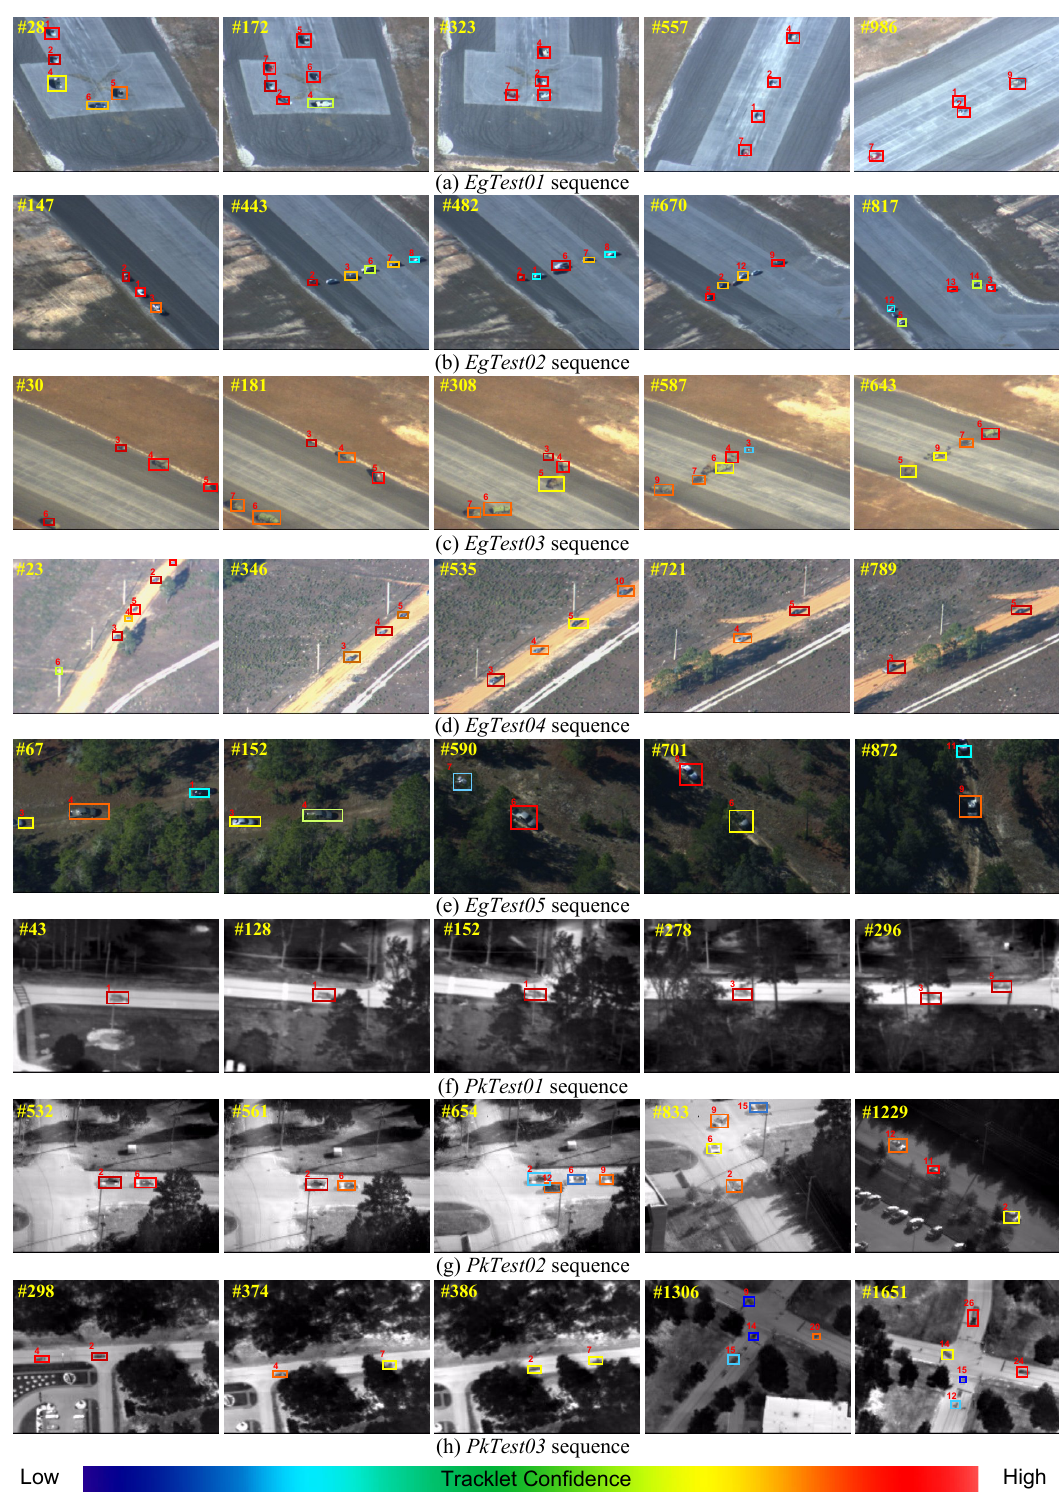
Figure 9. The results on eight sequences from the VIVID